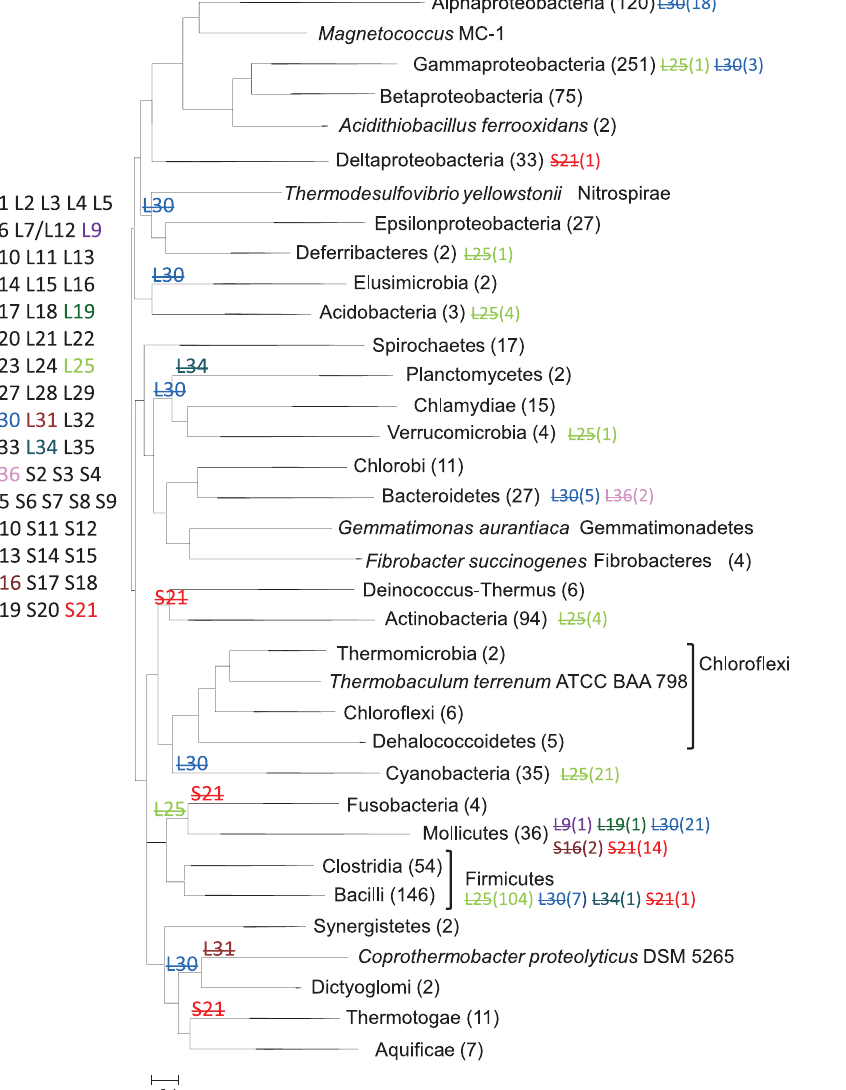
Figure 3. Phyletic patterns of r-proteins that are placed in the last common ancestor of Bacteria by Dollo parsimony. Proteins having full phyletic pattern are listed in black font. Losses are marked by a strikethrough font. Numbers in parentheses following taxonomic group names represent number of species in that group. Numbers in parentheses following r-protein names represent number of species on that branch that have lost this r-protein.